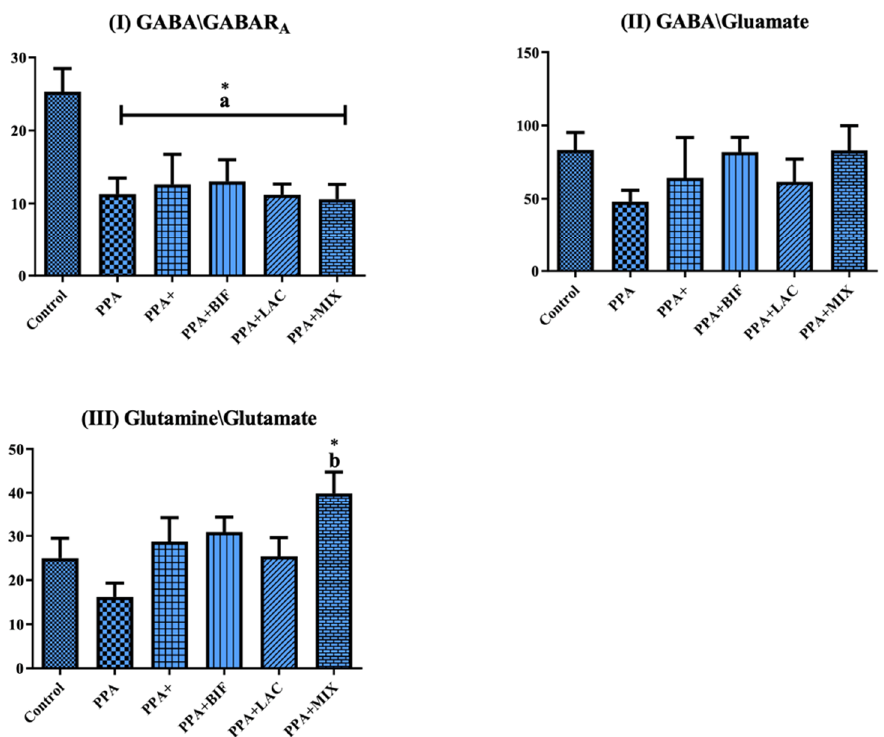
Figure 2. Ratios of ( I ) GABA/GABAR A , ( II ) GABA/glutamate, and ( III ) glutamine/glutamate in the brain homogenates of male western albino young rats in all groups. (a) Control vs. all groups and (b) PPA vs. all groups. (*) The mean difference is significant at p ˂ 0.001. Table 3. Means ± SD of the gene expression of GABAR A , GABAR B , and GABAR G selected subunits in the brain homogenates of male western albino young rats in all groups .